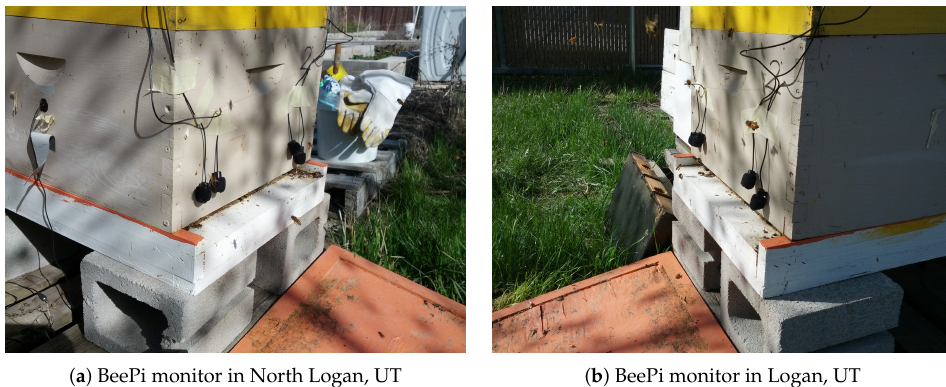
Figure 2. Microphones placed ≈ 10 cm above landing pads in BeePi monitors in North Logan, UT ( a ) and Logan, UT ( b ).